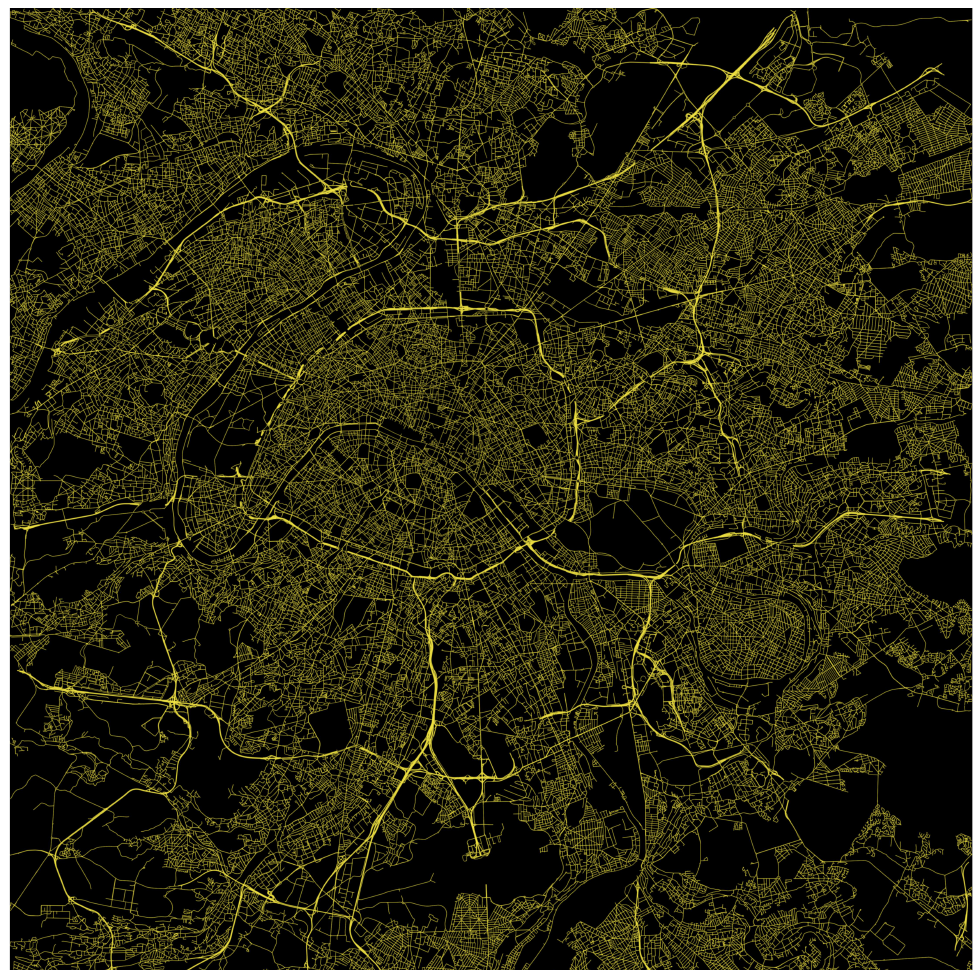
Figure 3. Reference NTL image of Paris extracted from OpenStreetMap.